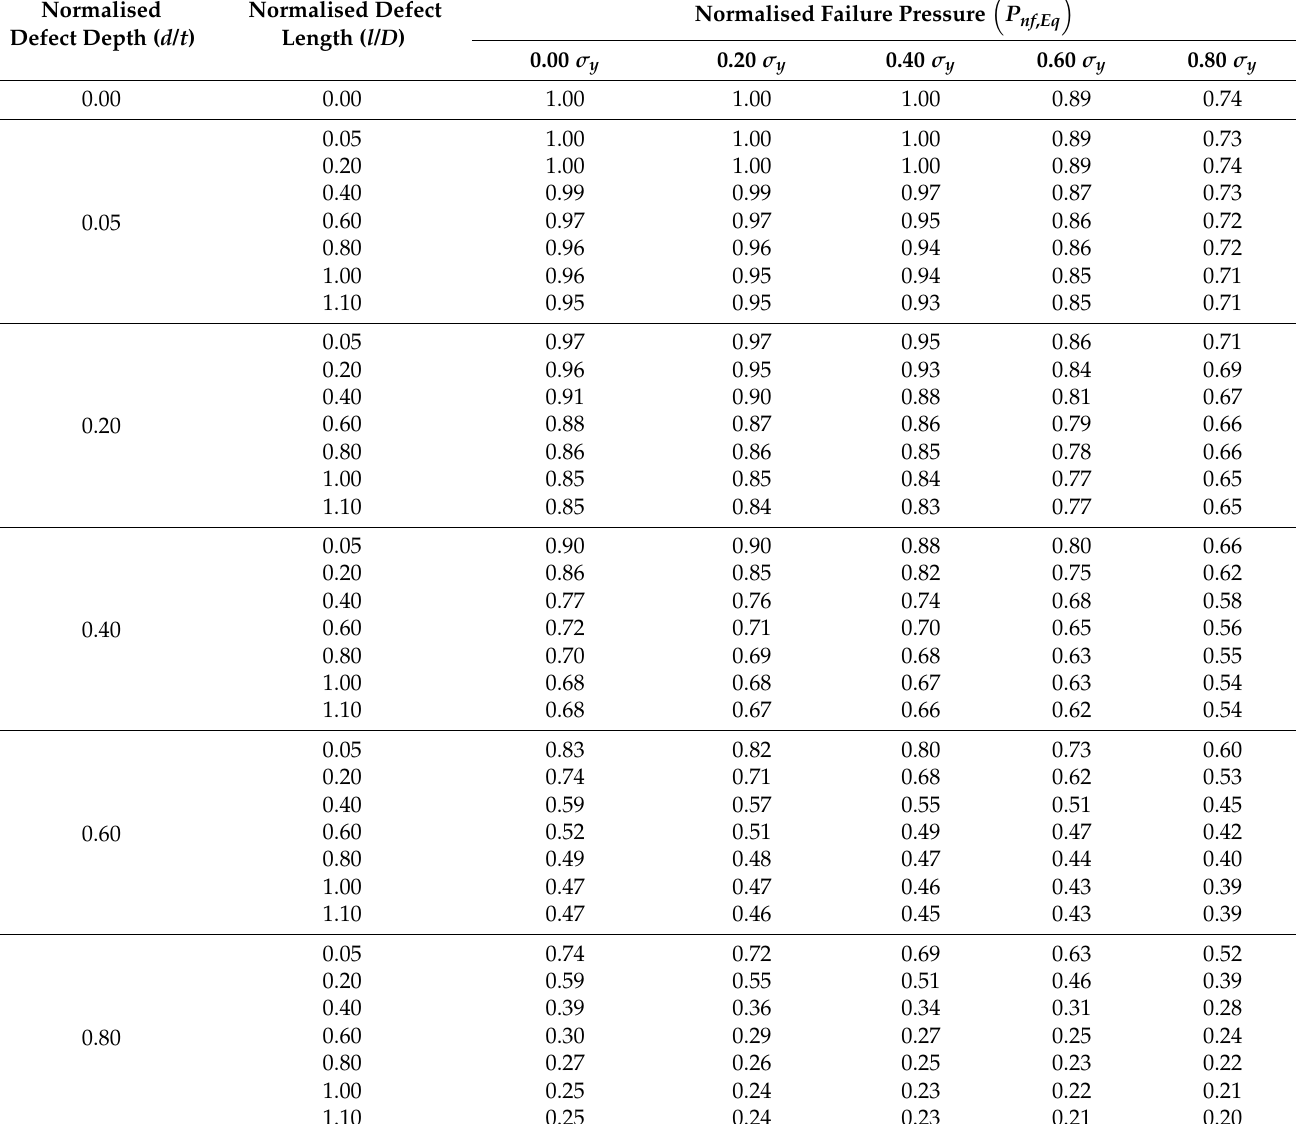
Table 10. Results of the extensive parametric study using the new corrosion assessment method for API 5L X80 pipe with single corrosion defect. Normalised Defect Depth ( d / t